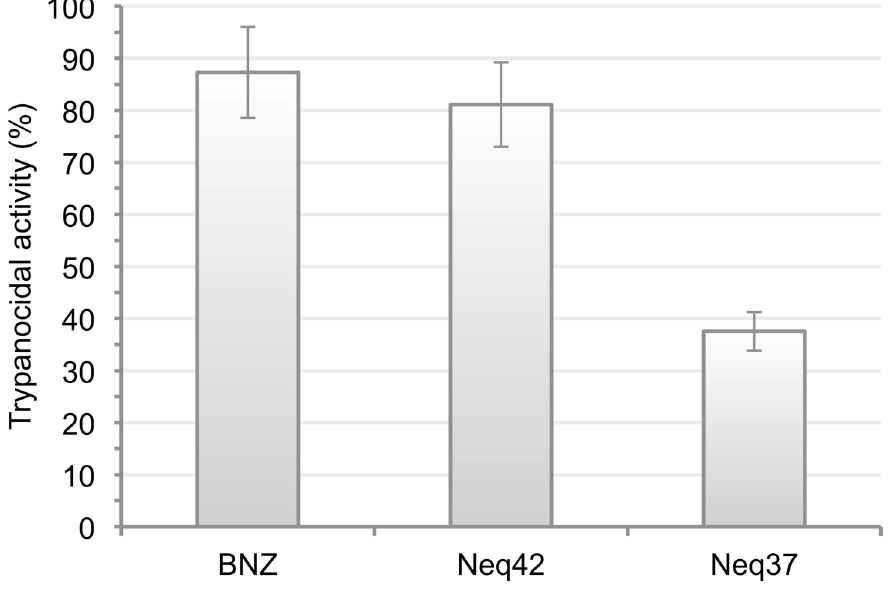
Figure 5. Preliminary trypanocidal activity of compounds Neq42 and Neq37 evaluated against the Tulahuen lacZ strain.